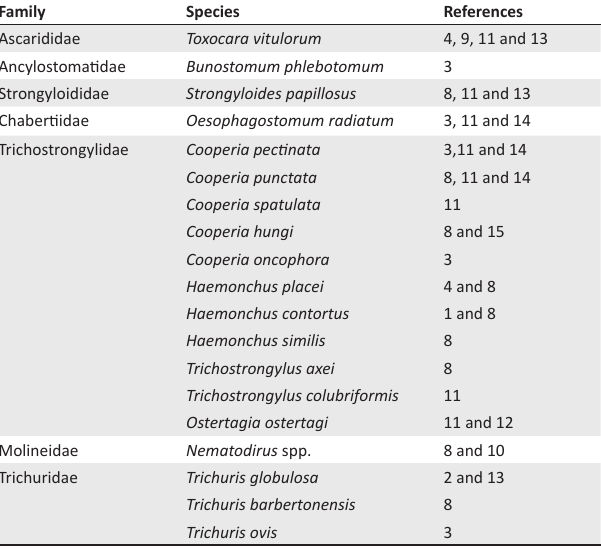
TABLE 1: Checklist of gastrointestinal nematode species reported in cattle in Zimbabwe.